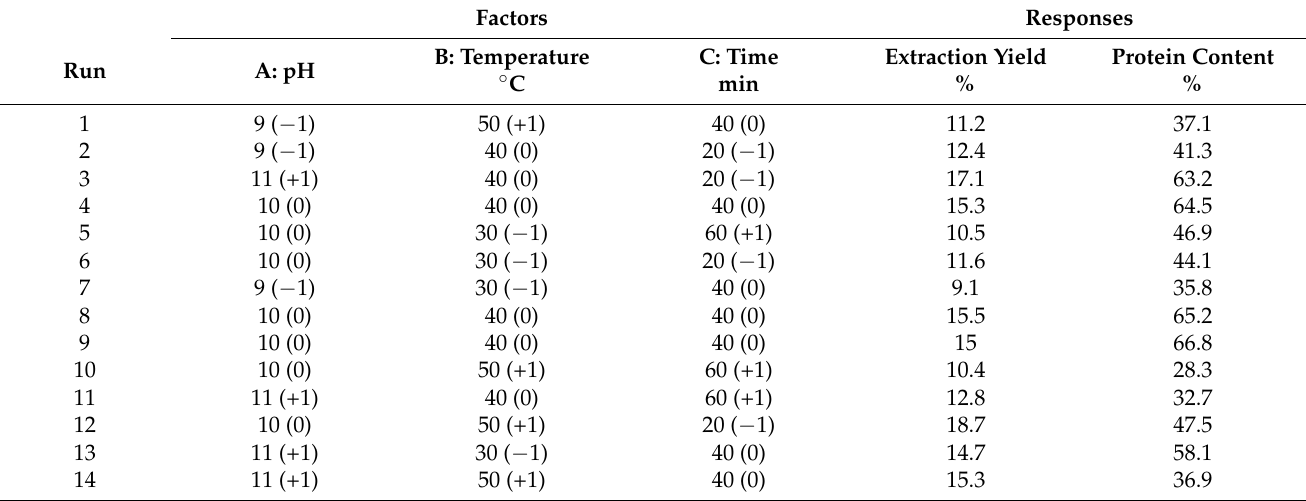
Table 1. Uncoded and coded values of the extraction-condition factors and observed